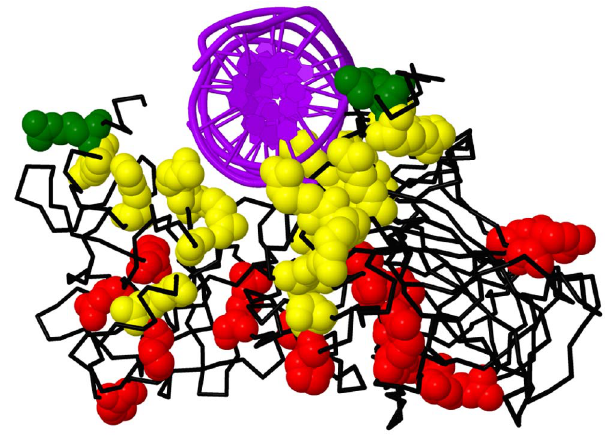
Figure 6. p53 DNA-binding domain variants. The DNA-binding domain of the p53 protein (black) bound to DNA (purple) [84]. Common somatic mutations (yellow) contact the DNA or stabilize the structure. Variants in our cohort (red) occur at residues distal to the DNA binding site except for Arg 283 (green).